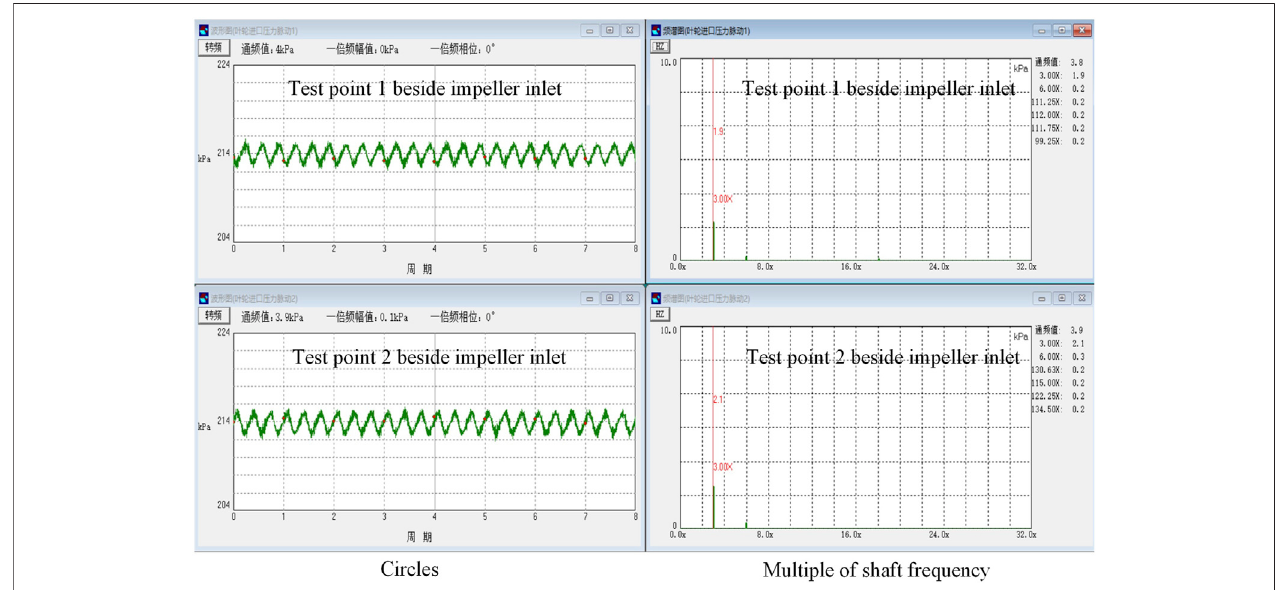
FIGURE 14 | Time frequency domain diagram of pressure by